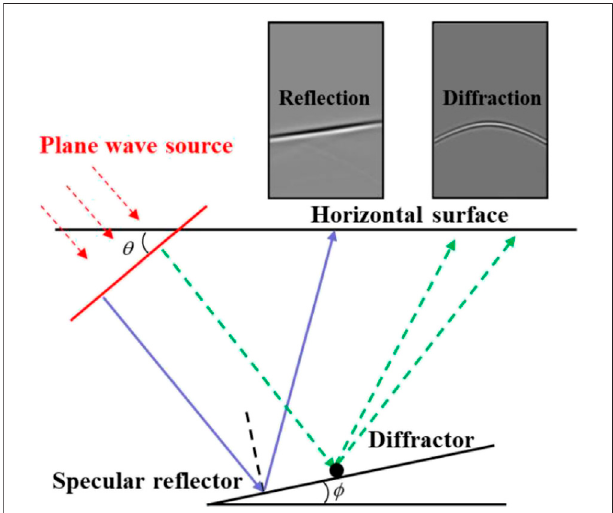
FIGURE 1 | Comparison of the re fl ection and the diffraction. As illuminated by the plane wave source, the seismic response of the re fl ection is linear while the response of the diffraction is